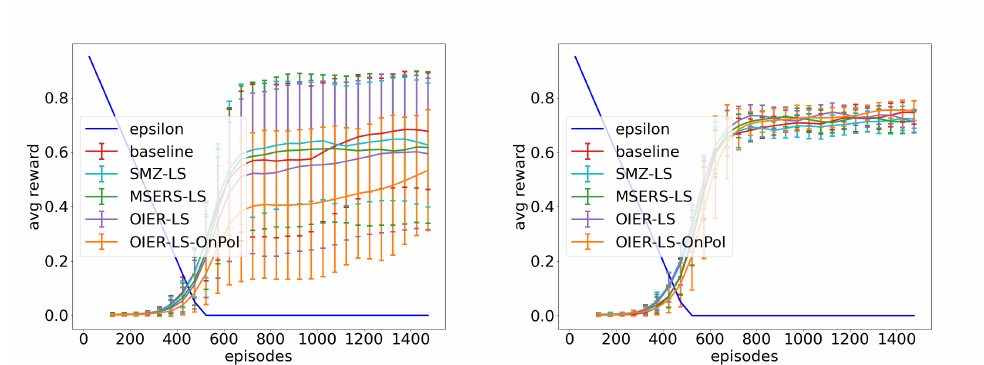
Figure A3. The results for the IER mode: LS and t expl = 500. state encoding: VE. state encoding: CE.